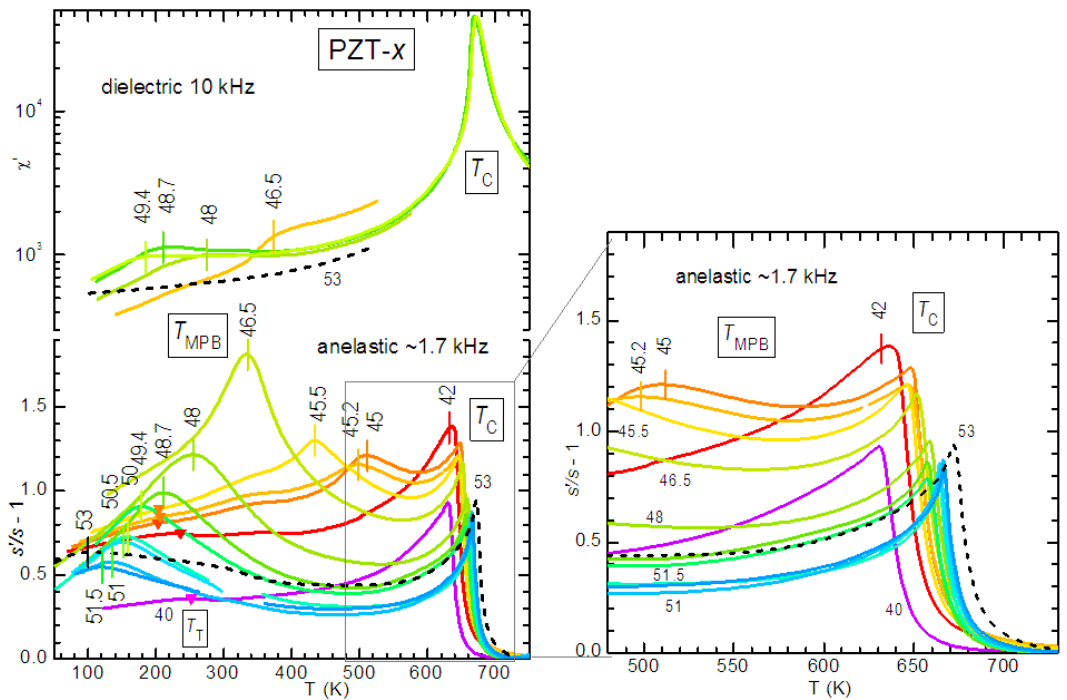
Figure 12. Real part of the compliance s = 1/ Y (1 − 2 kHz) and of the dielectric susceptibility (10 kHz) of PZT − x (data from Refs. [76,77]). The compositions x = %Ti are indicated next to each curve. The vertical bars indicate T C and T MPB while the triangles T T . On the right is a detail of the region around T C